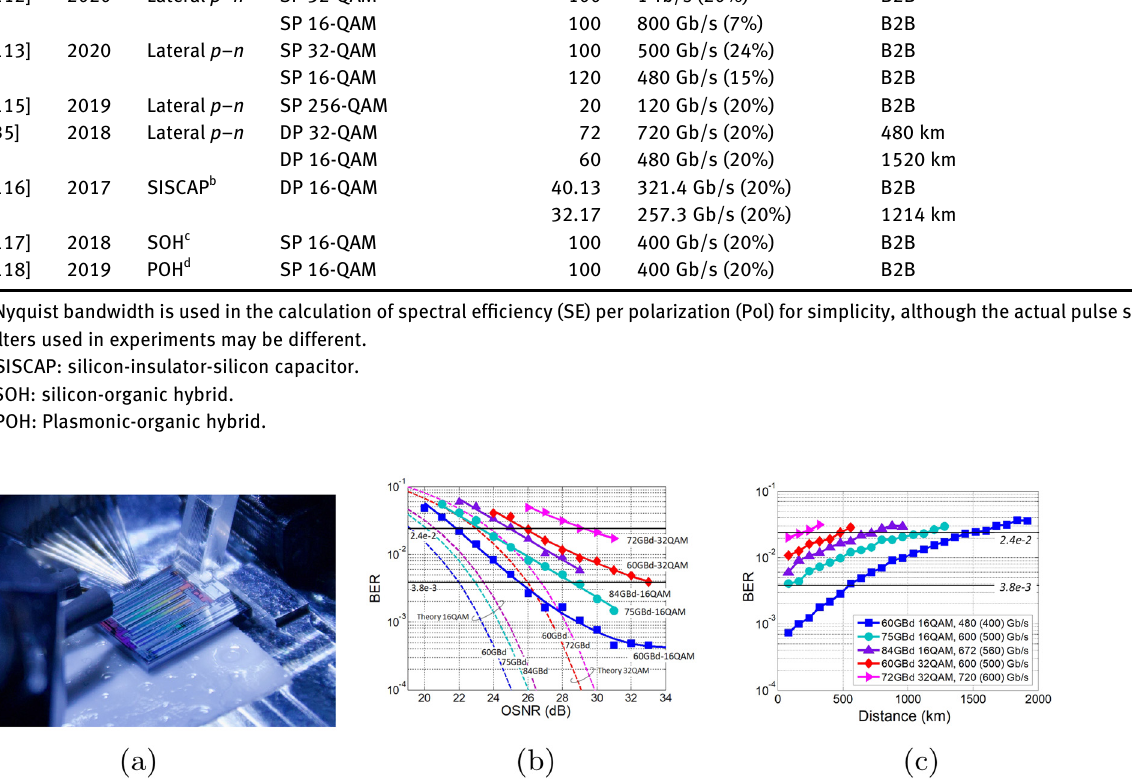
Figure 10: (a) Photograph of a silicon IQ modulator under test. (b) Back-to-back transmission performance for 60/75/84 Gbaud 16QAM and 60/72Gbaud32QAM.Dashedlines:theoreticalpredictionforanidealtransceiversystem.(c)Transmissionperformanceoverdistancefor60/ 75/84 Gbaud 16QAM and 60/72 Gbaud 32QAM. Raw bit rates are reported in the legend and post-FEC overhead bit rates in parentheses